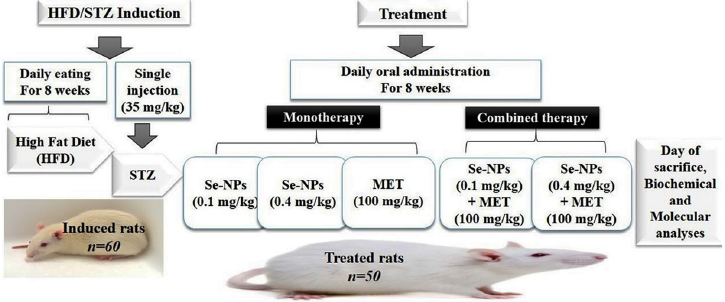
Fig 1. Experimental design for the study of HFD/STZ-induced T2DM in rats post-treatment with Se-NPs and MET monotherapy and combined therapy.